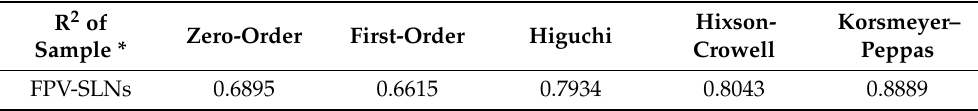
Table 2. Kinetics parameters favipiravir from the FPV-SLN formulation fitted to mathematical kinetic model. * It should be noted that only cumulative release of FPV until 2 h is fitted to the model. R 2 of Sample *